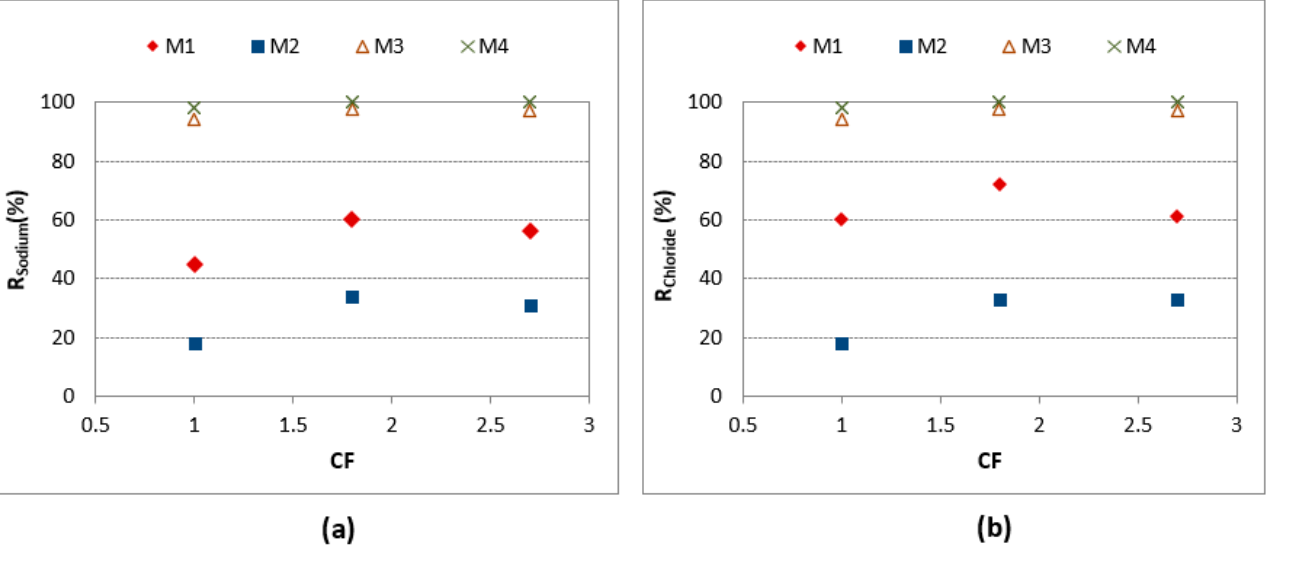
Figure 9. Influence of concentration factor (CF) on monovalent ion rejections: ( a ) sodium ion, ( b ) chloride ion.